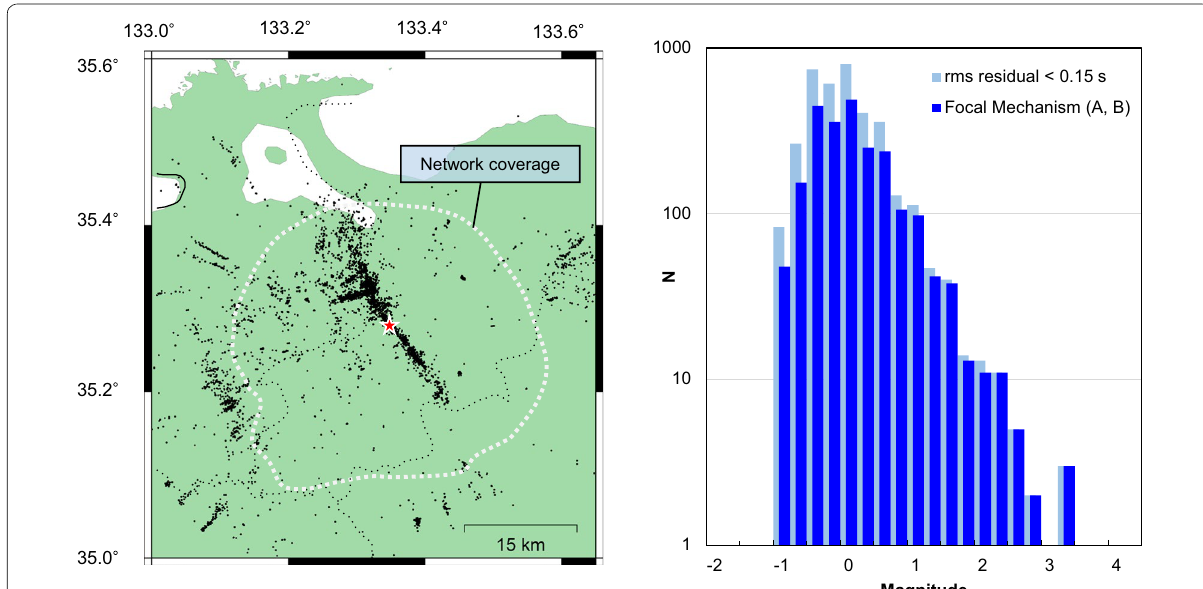
Fig. 2 Left) Map of the epicenters of the events detected during the observation period. The white dotted line indicates the area covered by the network. Right) Histogram of the magnitude of the detected earthquakes. Light blue bars show the number of earthquakes detected. Detection completeness is an approximate magnitude of 0.5. Dark blue bars indicate the number of focal mechanisms with enough −